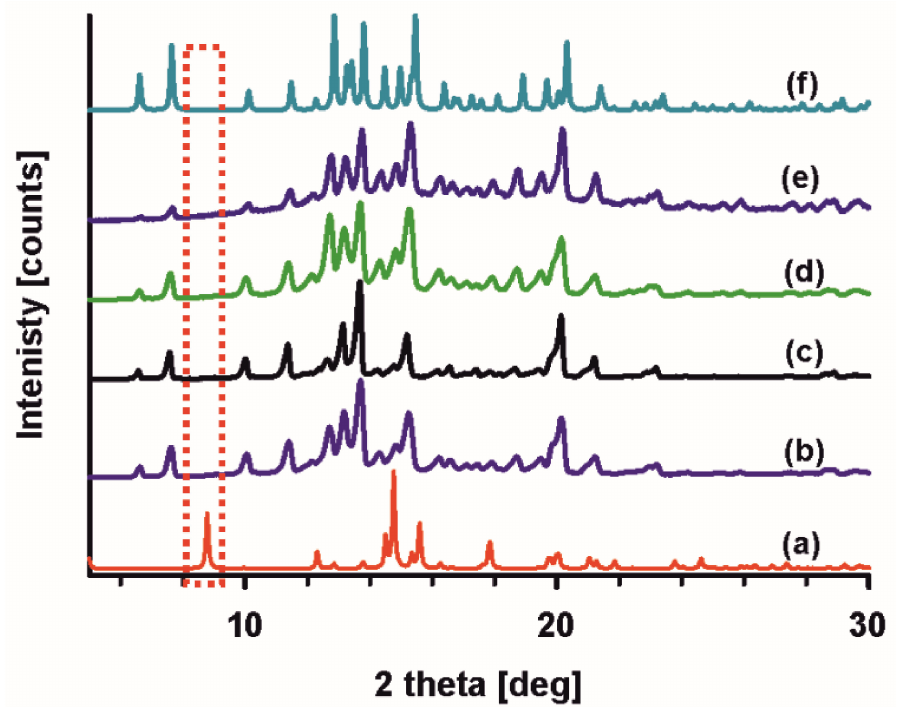
Figure 2. Powder diffraction patterns of but-OA simulated from single crystals belonging to ( a ) P 2 1 and ( f ) R 3 space groups, obtained during recrystallization from ( b ) ethyl acetate, ( c ) 2-propanol, ( d ) ethanol, and ( e ) dimethylsulfoxide. The intensity characteristic for the P 2 1 form is marked with a red, dotted rectangle.